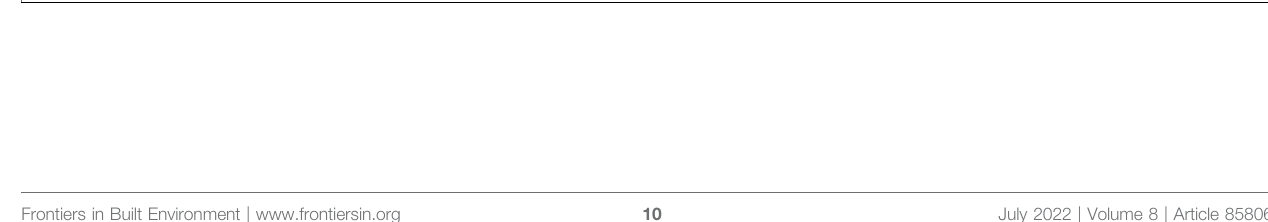
Frontiers in Built Environment |